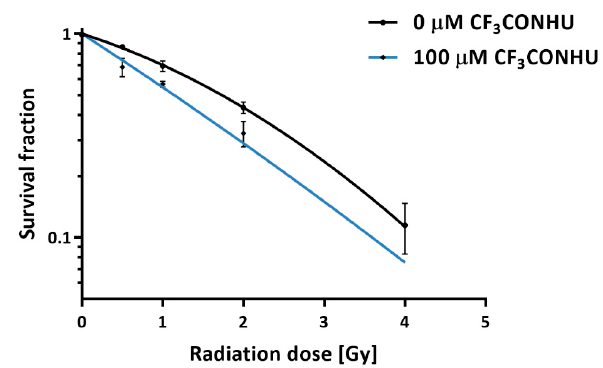
Figure 9. Effect of 100 µM 5-( N -trifluoromethylcarboxy) aminouracil treatment combined with irradiation on the survival of PC3 cells. Data obtained with the clonogenic assay. Experiments were performed at least three times, and the results are expressed as mean ± standard deviation. The average plating efficiencies for the controls with and without pretreatment are equal to 40.66% (0 µM), and 42.09% (100 µM)